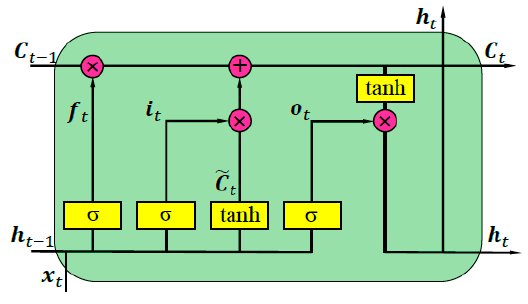
Figure 3. The long short-term memory (LSTM) unit.